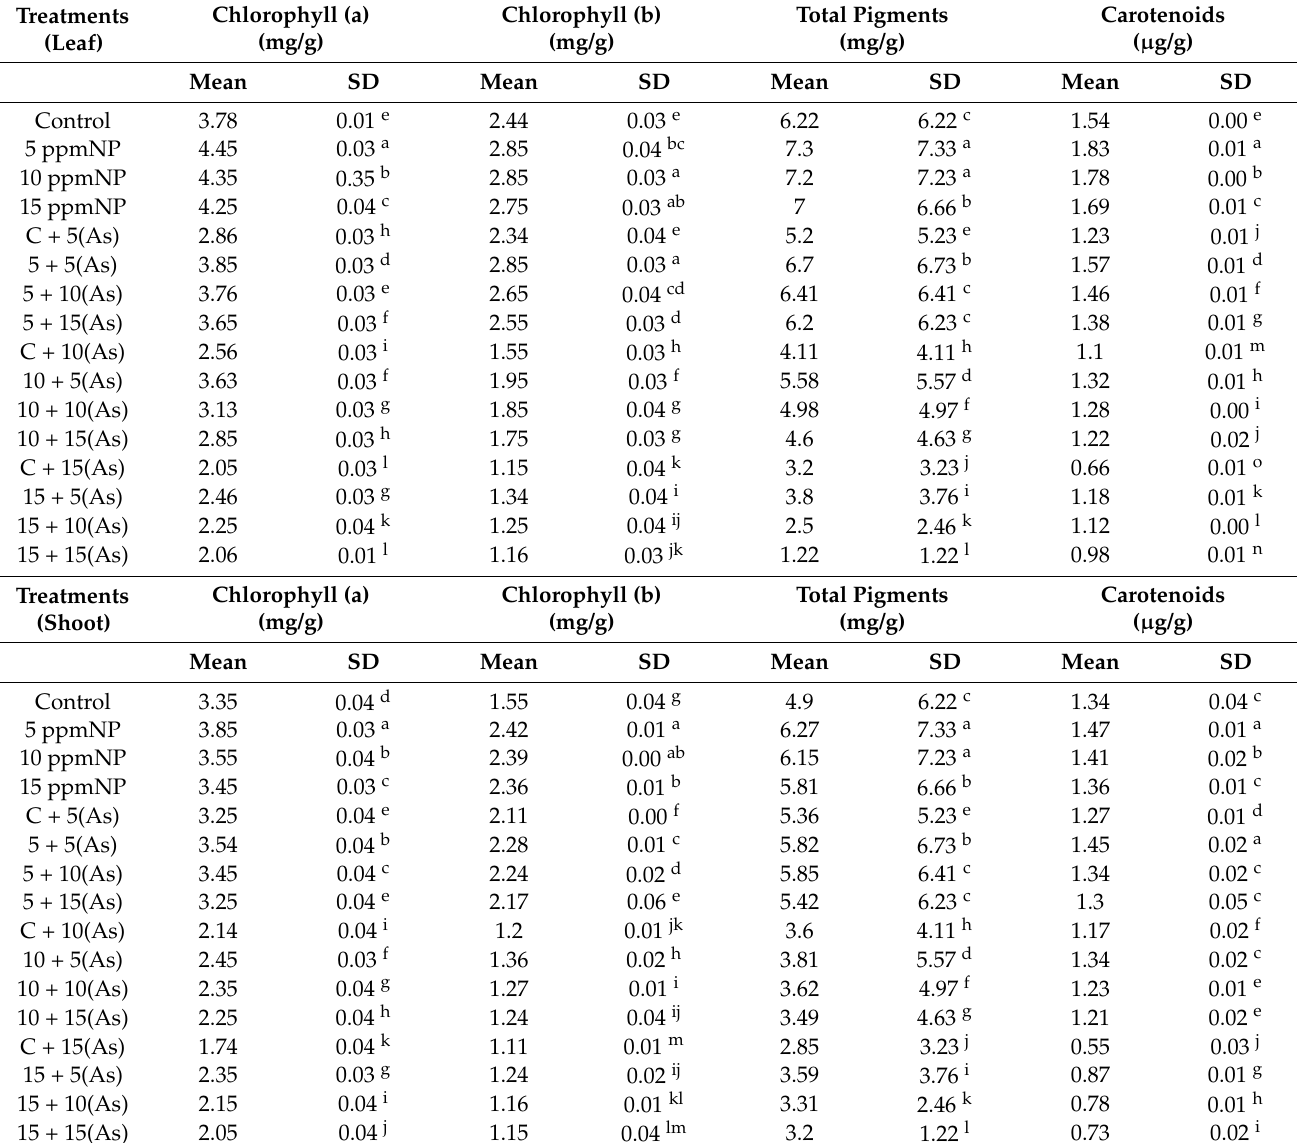
Table 1. Effect of Bacillus subtilis -synthesized iron oxide nanoparticles on photosynthetic pigment in the leaves and shoots of rice ( Oryza sativa L.) in arsenic-contaminated water. Different letters indicate significant differences ( p < 0.05) between